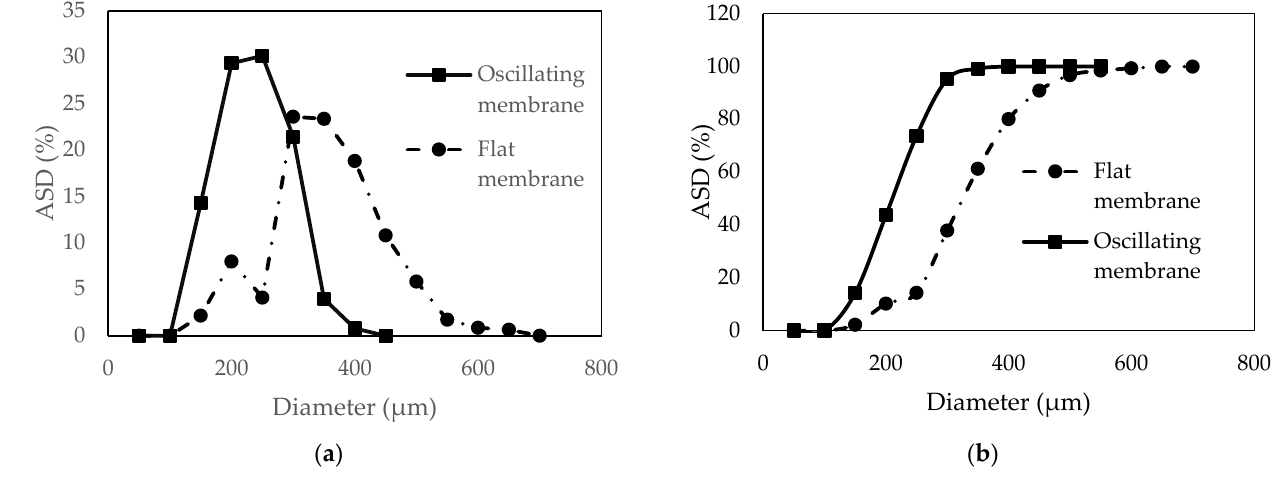
Figure 4. ( a ) Agglomerate size distribution (ASD) and ( b ) cumulative size distribution, based on number of spherical agglomerates formed at flux = 240 Lm −2 h −1 , at 800 RPM, nickel membrane d p = 18 µm.